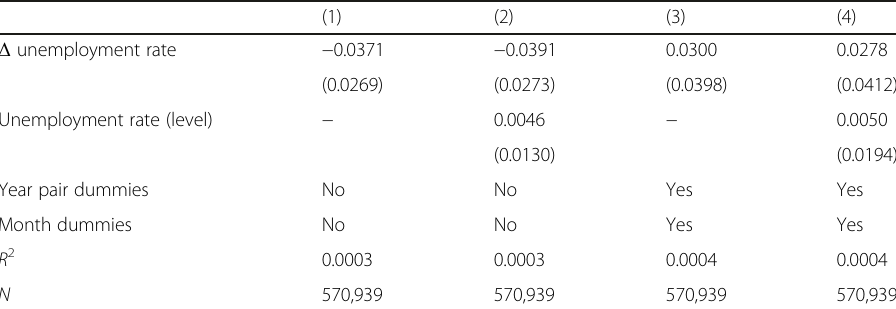
Table 7 Longitudinal analysis of multiple job